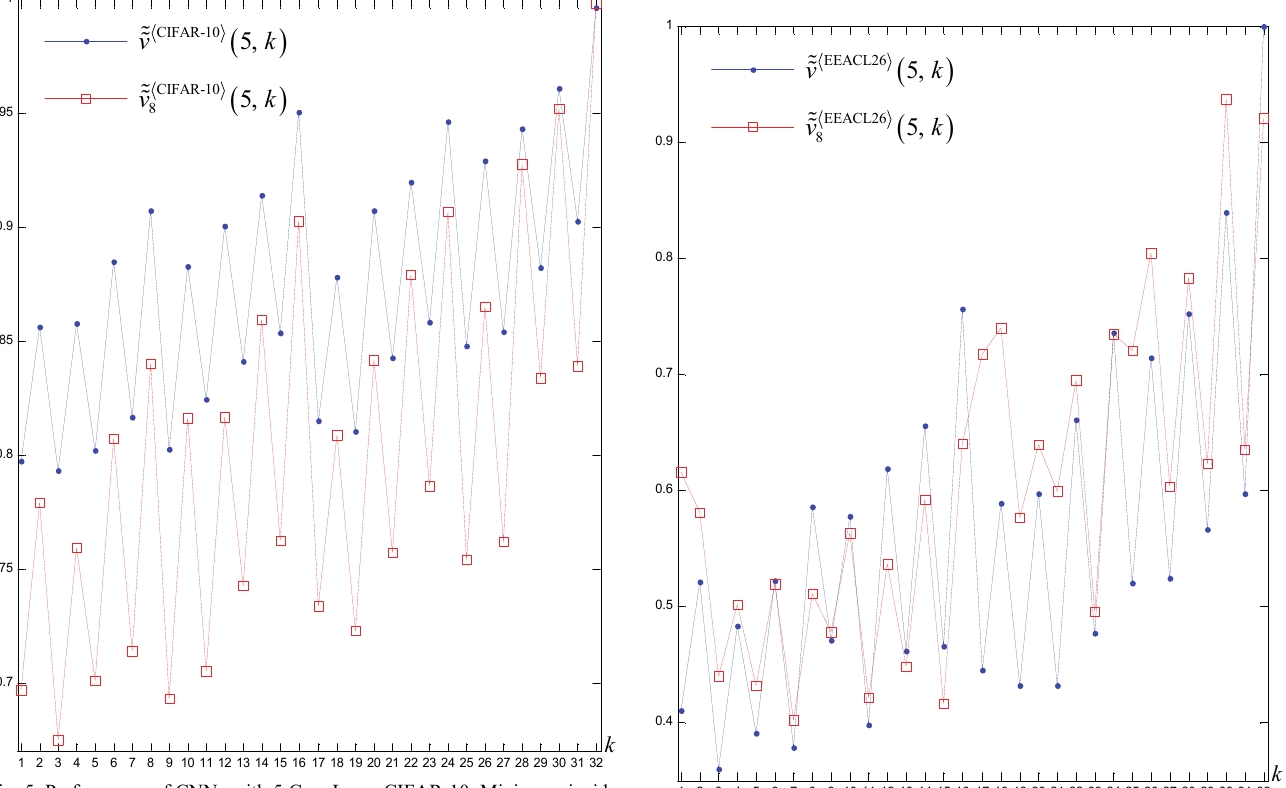
Fig. 7. Performance of CNNs with 5 ConvLs on EEACL26. The minimum of (9) is the same ( k = 3). The minimum of (10) is moved to the right ( k =